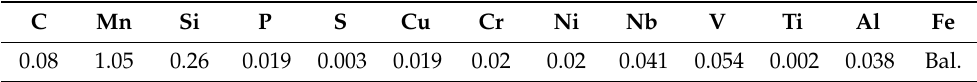
Table 1. Chemical composition of the X52 steel (wt.